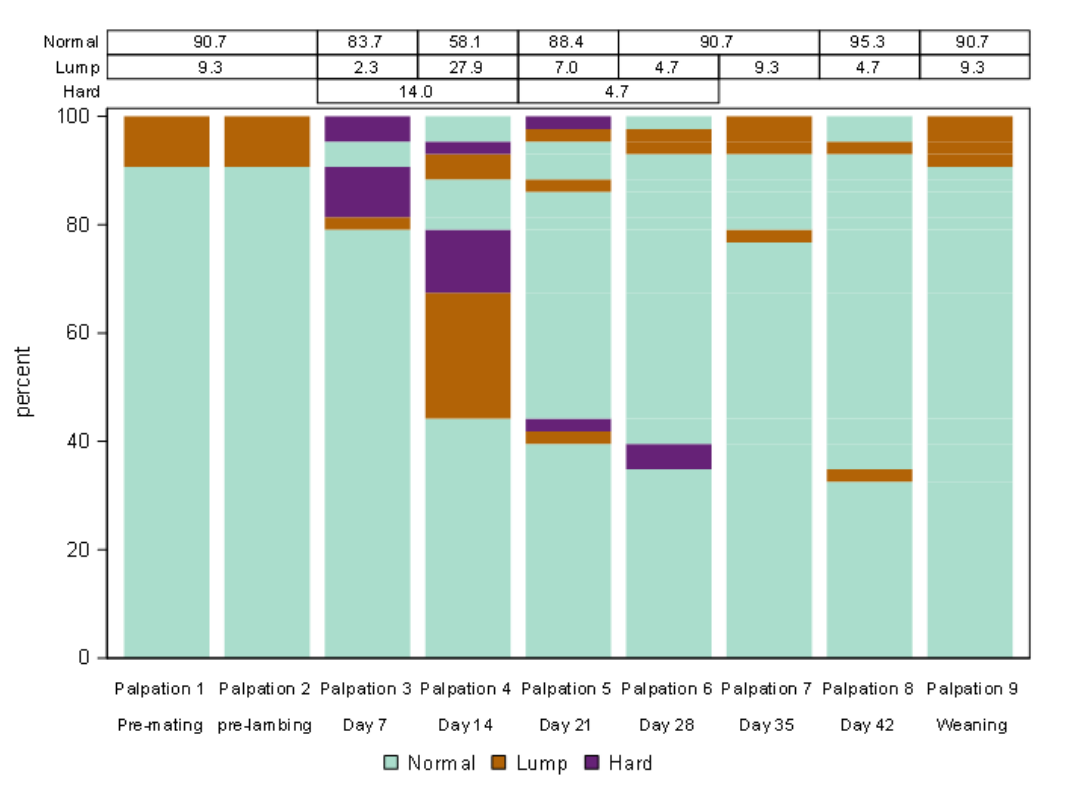
Figure A4. Lasagna plot of palpable udder half defects (hard, lump, and normal) in the first six weeks of lactation in non-dairy Romney ewes (Study B). Udder examination was undertaken at weekly intervals from 43 udder halves that did express milk. Note: Within each plot, each bar shows a different udder scoring event (i.e., time) while the different colours within each bar represent the defect categories. The data in the table at the top of the plot designates the percentage of each udder half defect category at each event, which corresponds to the percentage of each colour at each event. Change in defect category over time of each udder half can be tracked by following longitudinal transitions across the udder scoring events of stacked bars. Note that an udder half that did not express milk refers to an udder half that did not express milk at all on at least four occasions and expressed less than 100 g/day on the other two occasions.